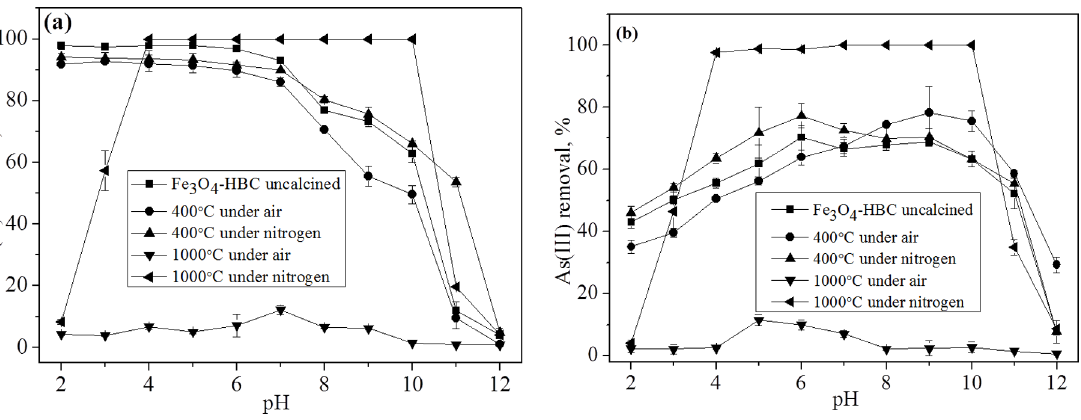
Figure 4. Effects of initial solution pH on the removal of As(V) (a) and As(III) (b) (Experiment conditions: adsorbent dose =0.02 g 100 mL 2 1 , temperature =25 ± 0.8 6 C, agitation speed =150 rpm, initial concentration =100 m g L 2 1 , contact time =14 h).